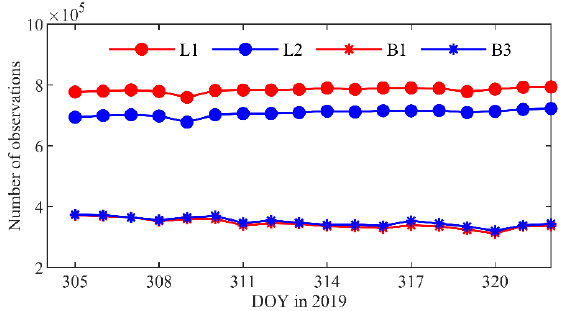
Figure 2. Daily numbers of GPS and BDS2 observations for TH ‐ 2A.